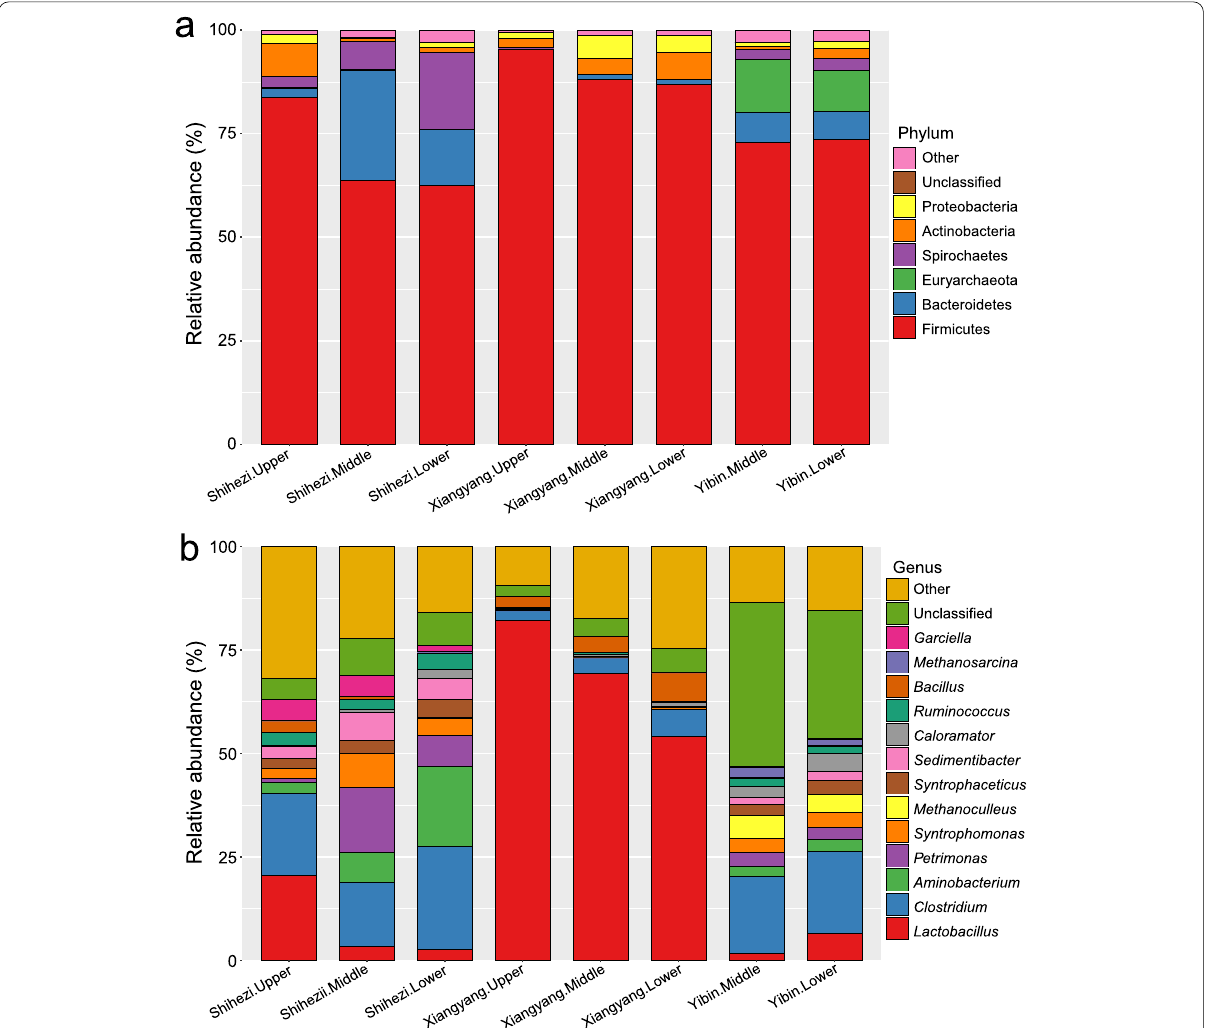
Fig. 1 Prokaryotic composition of pit muds at the phylum ( a ) and genus ( b ) levels, determined via Illumina MiSeq sequencing of 16S rRNA